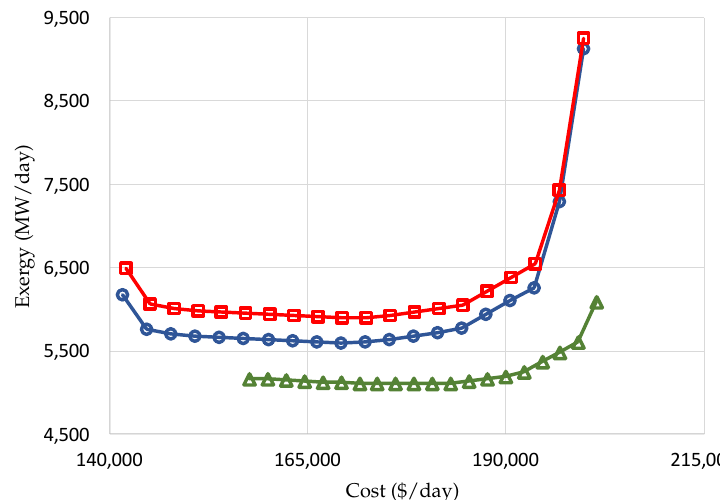
Figure 11. Cost vs. Exergy Pareto set for Scenario 1 (– ◦ – blue), Scenario 2 (– (cid:3) – red), and Scenario 3 (– (cid:52) –